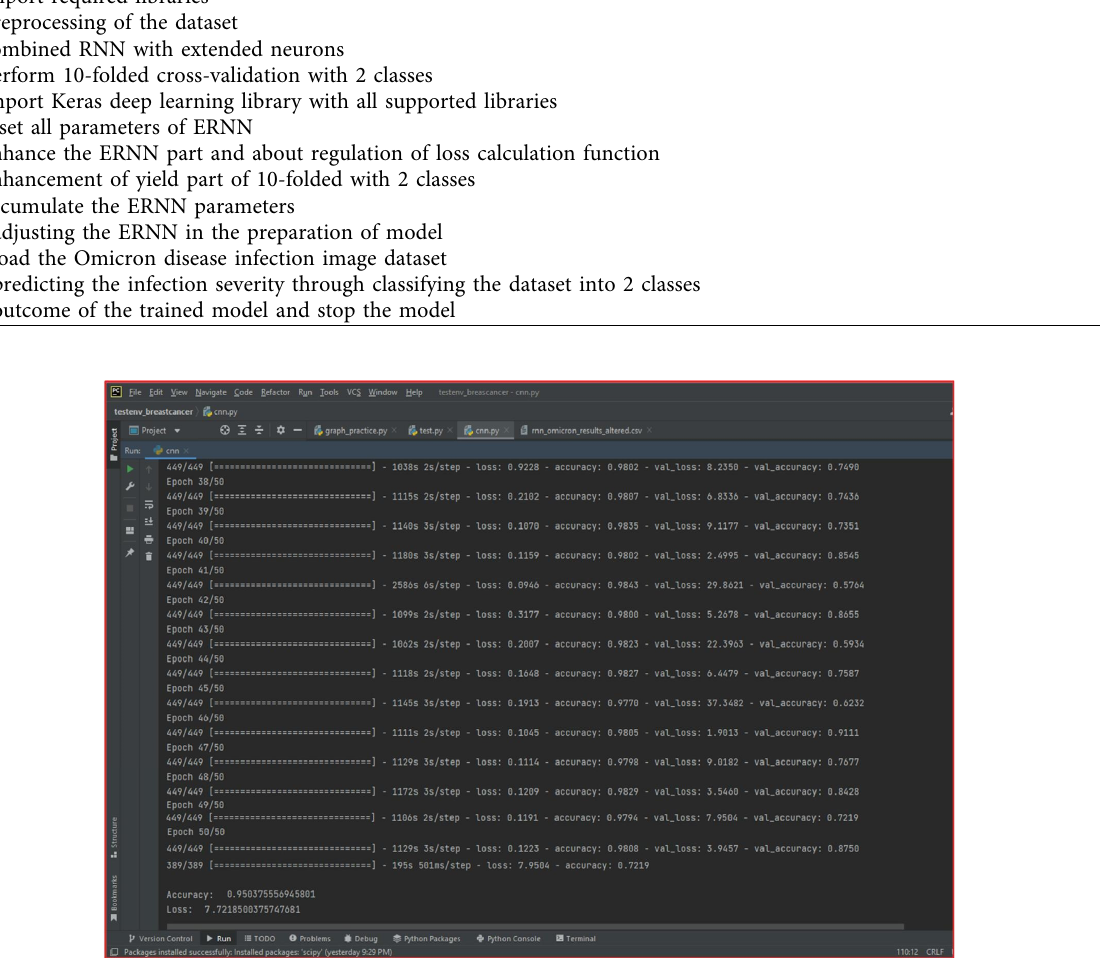
Figure 10: Executing fow of ECNN on the training and testing